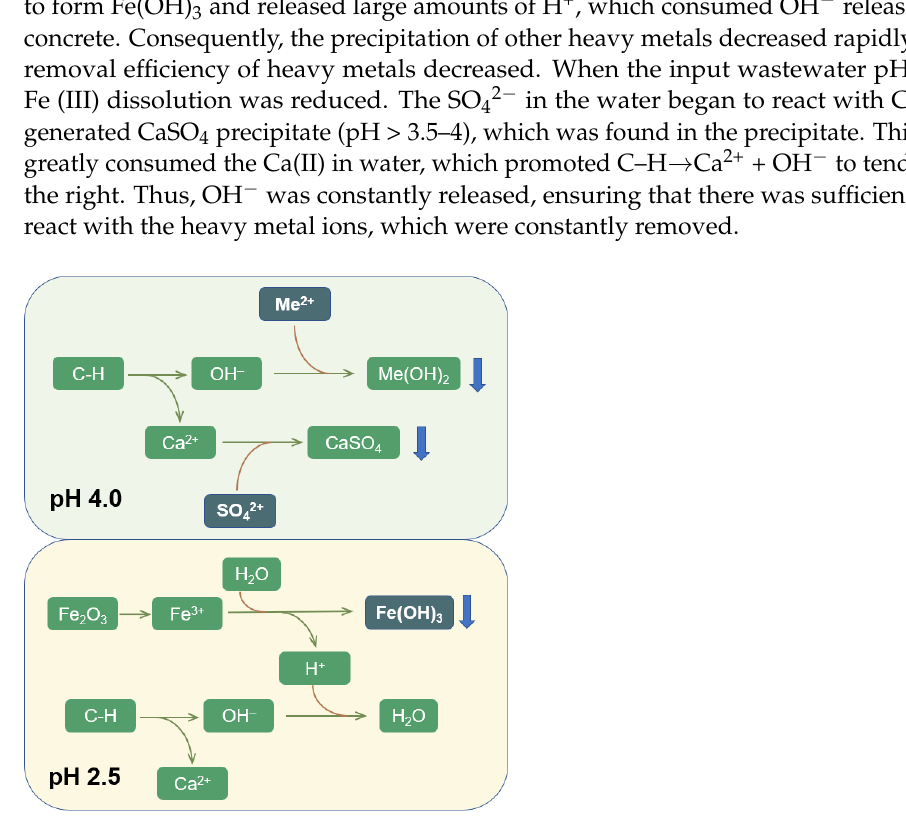
Figure 7. SEM patterns of RMPC after reaction.